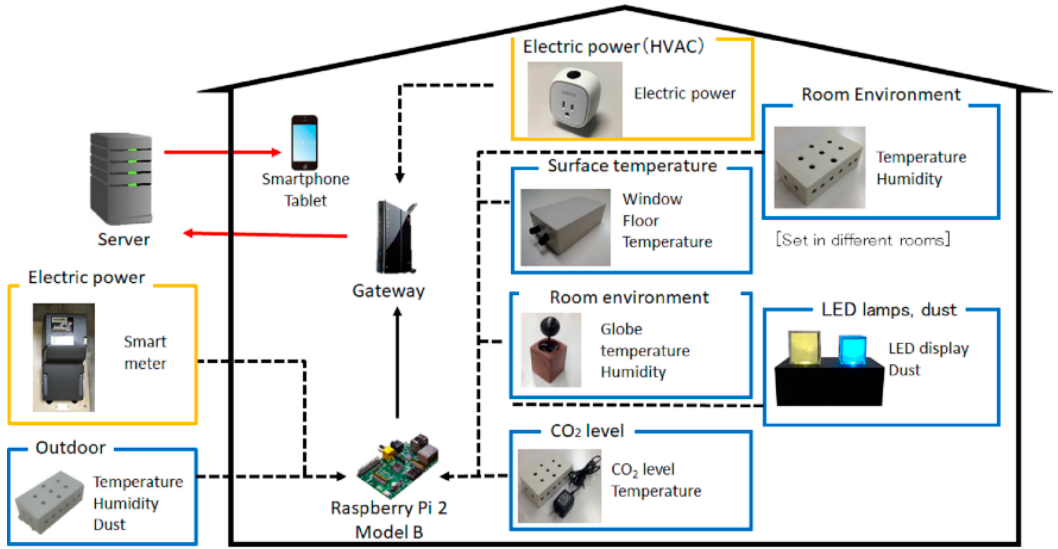
Figure 4. House energy management system (HEMS) installed in smart houses for the Urban Design Center Misono (UDCMi) project. Environmental and electric data are collected at the gateway and sent to the server for storage. Various home services using these data are provided for UDCMi.